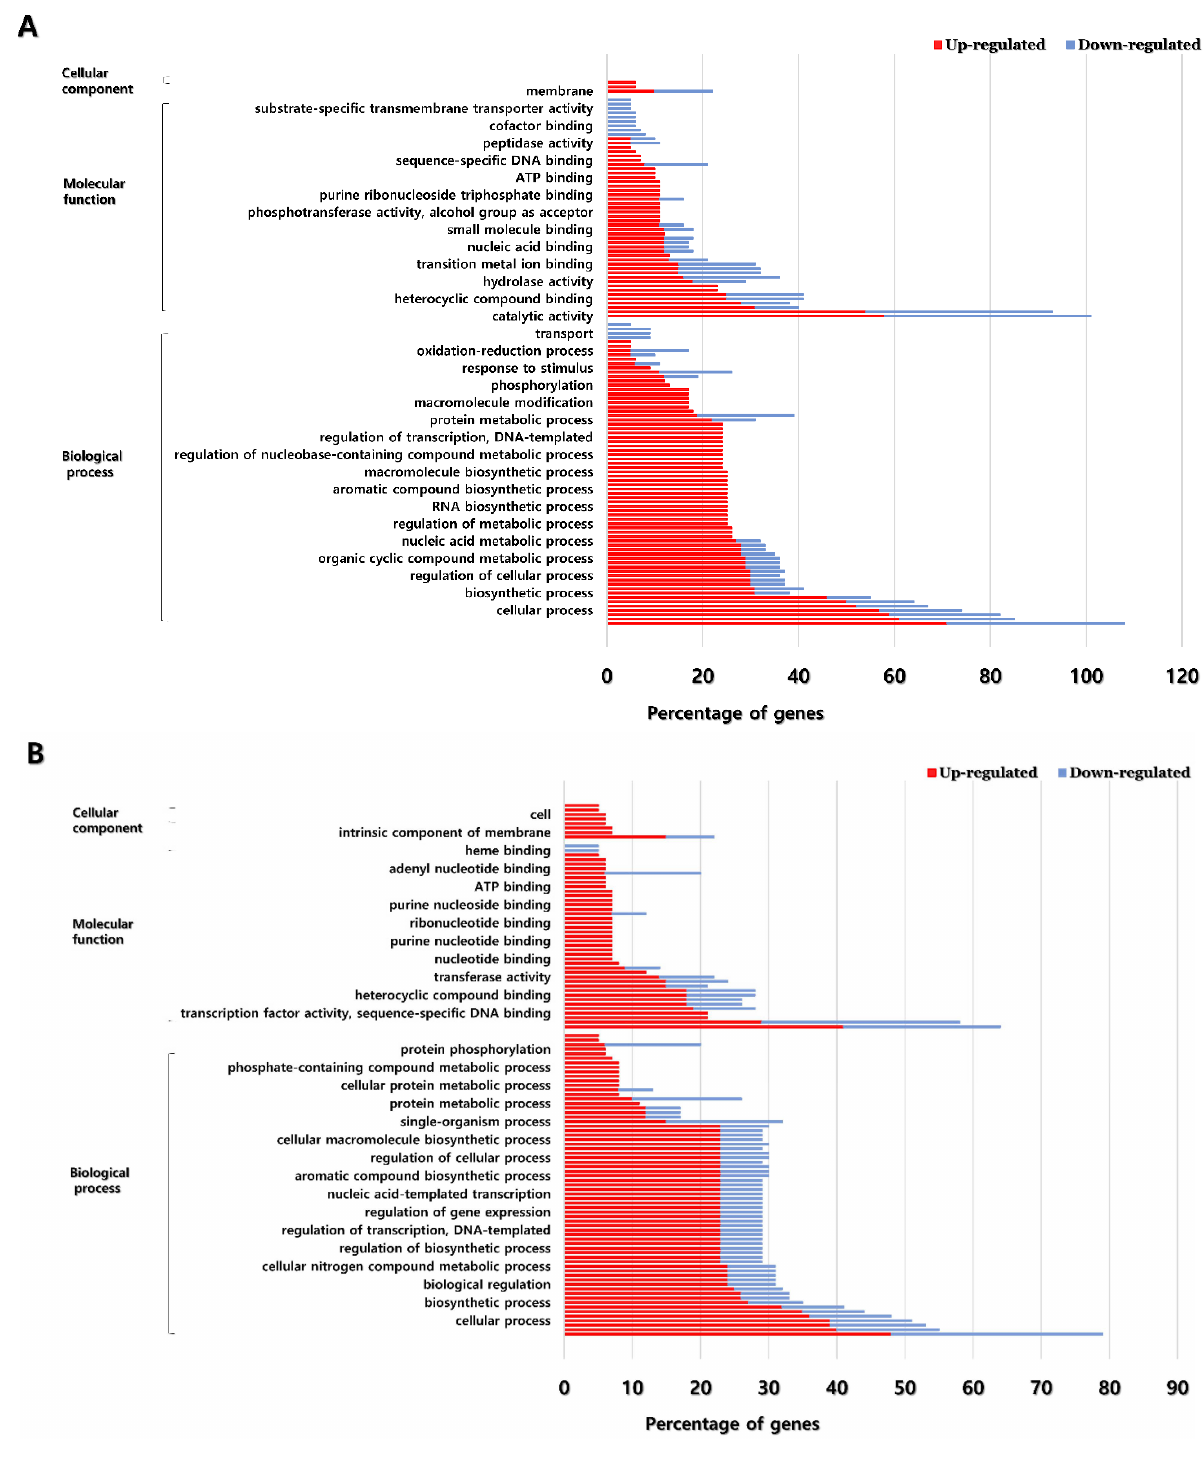
Figure 3. GO enrichment analysis for DEGs in leaves ( A ) and root ( B